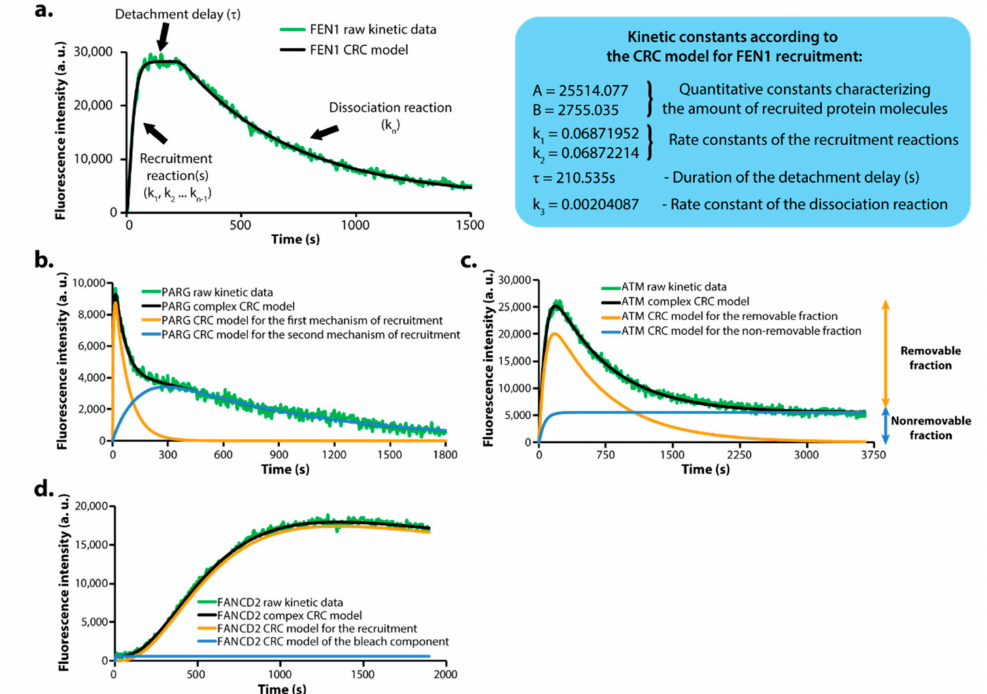
Figure 3. CRC mathematical modelling provides in-depth understanding of the kinetics data. ( a ) Gen- eral overview of the features of the Consecutive Reactions Chain (CRC) model. ( b ) Modelling the complex kinetic behavior of a protein which is recruited to DNA damage sites by two different mechanisms. The overall CRC model for PARG kinetics is the sum of the two individual CRC models describing the two separate mechanisms for its recruitment. ( c ) Modelling the complex kinetics of a protein which possesses both a removable and a non-removable fraction at DNA damage sites. ( d ) Modelling protein kinetics with not fully compensated bleaching following micro-irradiation. The bleaching component can easily be eliminated by means of the CRC model to facilitate the further kinetics